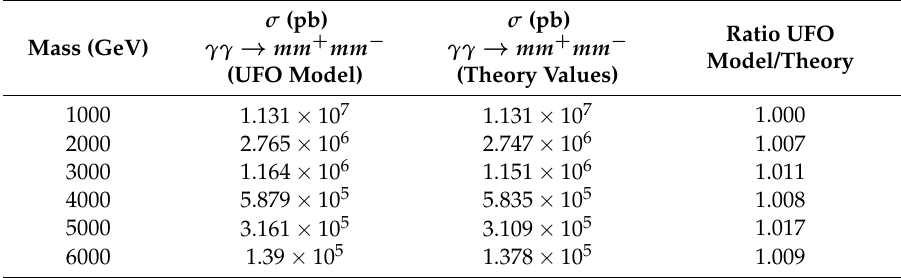
Figure 3. The Feynman Diagrams produced by M AD G RAPH for the spin 1 magnetic monopoles. Here “mm+” suggests monopole, “mm − ” shows the anti-monopole, and “a” describes the photon. Table 5. The cross-section for the spin 1 monopole as obtained by the theory and the M AD G RAPH UFO model for the β -independent coupling when no PDF is used and the center-of-mass energy is 13 TeV. The fourth column shows the ratio of the cross-sections of the UFO model to that of the theoretical prediction. The ratios, being very close to 1, suggest excellent agreement between the theory and the M AD G RAPH model